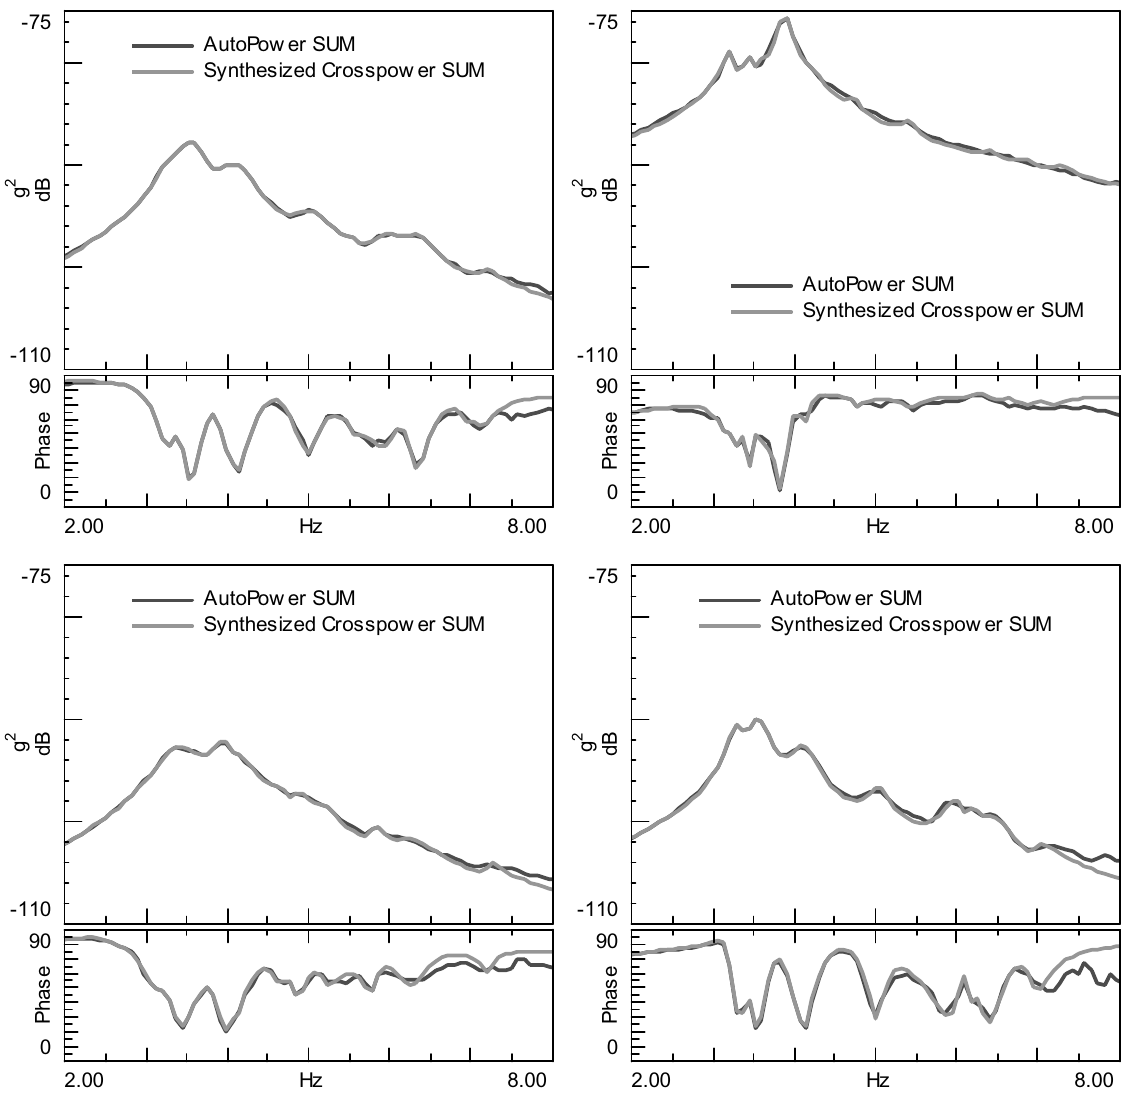
Fig. 14. Sum of measured spectra (red/black) and sum of synthesised PolyMAX spectra (green/grey) for different events: Filling – 1 st goal – sitting – leaving. – Enlarging the segment length yields more stable results (Bottom diagram of Fig. 15 vs. Top diagram)